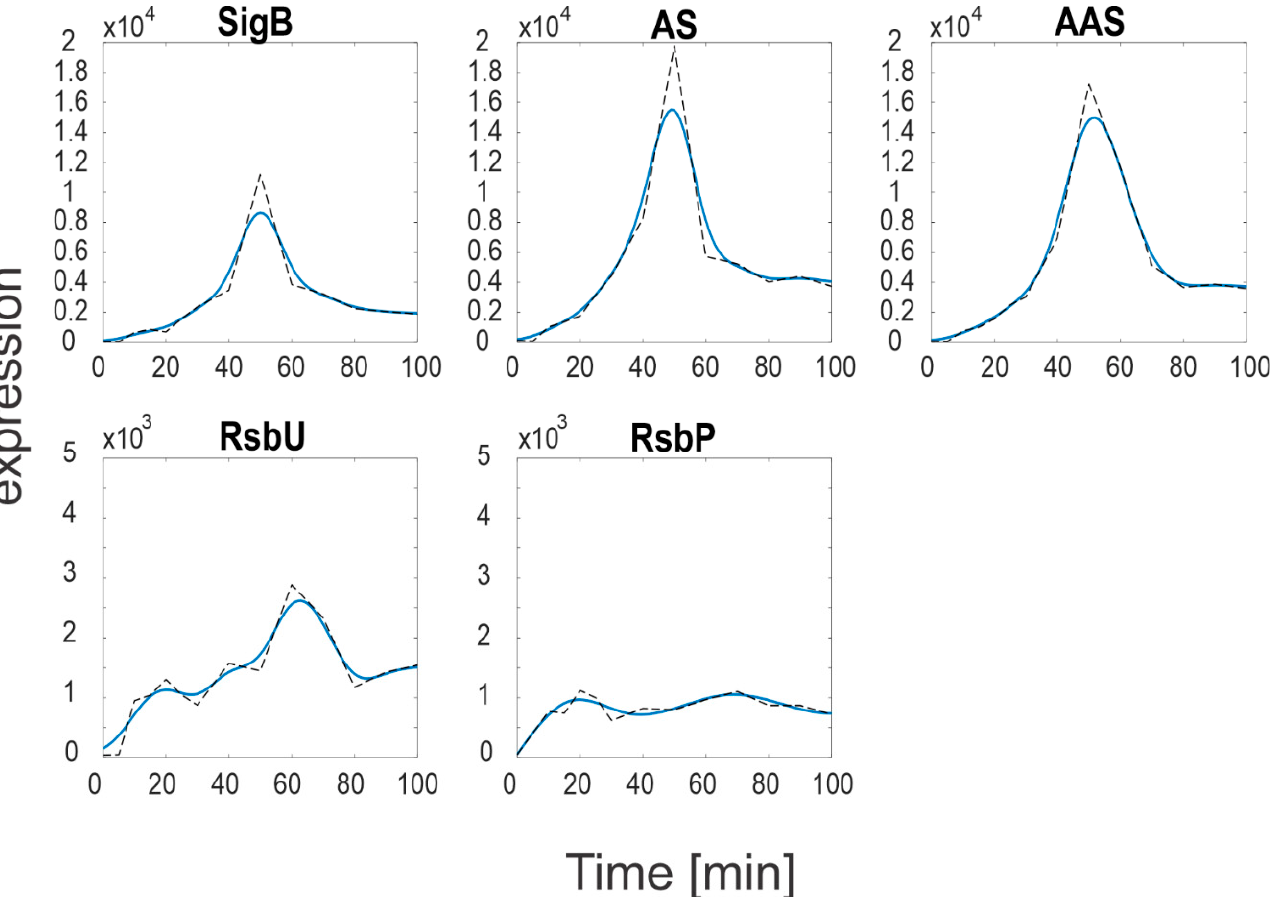
Figure 2. Measured (dashed line) and approximated (solid line) expression profiles of genes of the SigB regulatory network. S-measured total amount of SigB, AS-measured total amount of RsbW, AAS-measured total amount of RsbV. Note a different scale for RsbU and RsbP that is two orders of magnitude lower than that of the SigB operon.